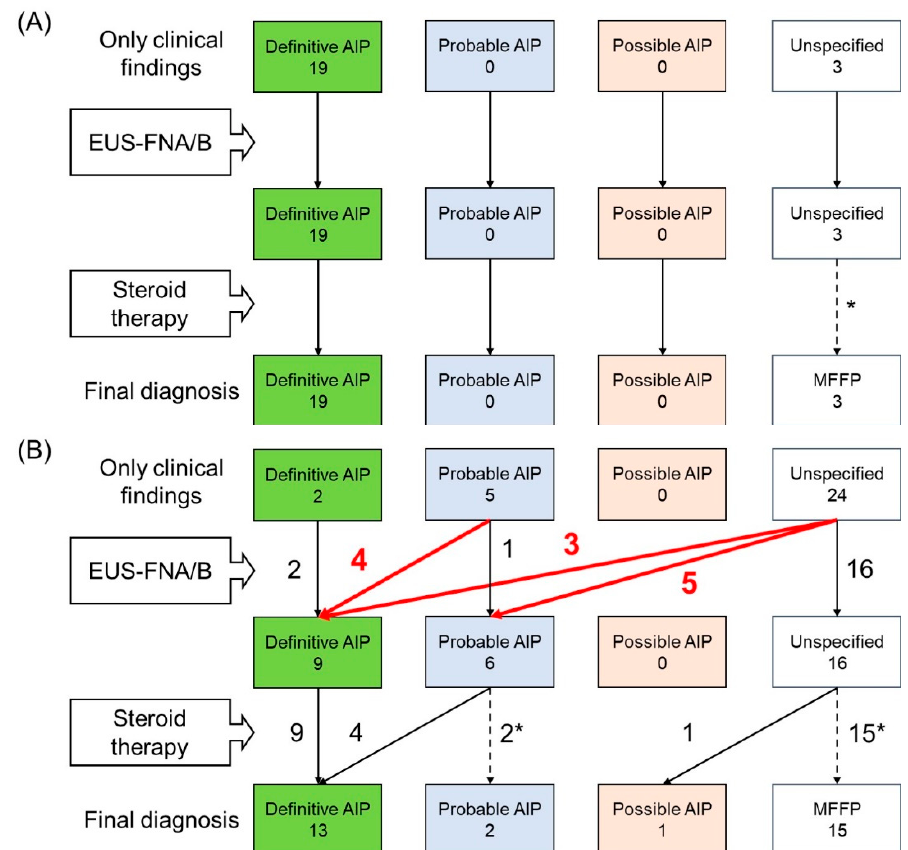
Figure 1. Diagnostic flow of autoimmune pancreatitis according to Japanese Clinical Diagnostic Criteria for Autoimmune Pancreatitis 2018 in patients with diffuse enlargement of the pancreas ( A ) and in those with focal enlargement ( B ). AIP, autoimmune pancreatitis; EUS-FNA/B, endoscopic ultrasonography-guided fine needle aspiration/biopsy; MFFP, mass-forming focal pancreatitis. * They did not receive steroid therapy.